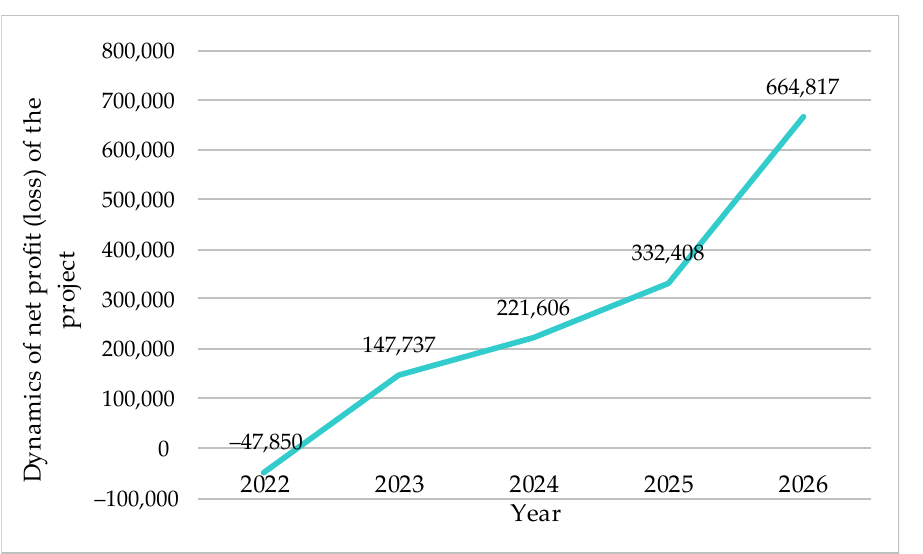
Figure 6. Dynamics of projected gross profit of Hideez Technology in 2022–2026, US dollars. Due to the significant cost of promotion of Hideez Key at the initial stage, in 2022 Hideez Technology LTD expects to incur a total loss of USD 47,850. Already, rapid growth is projected for 2023—net profit will reach USD 147,737, and by the end of 2026 it will increase 4.6 times (Figure 7).